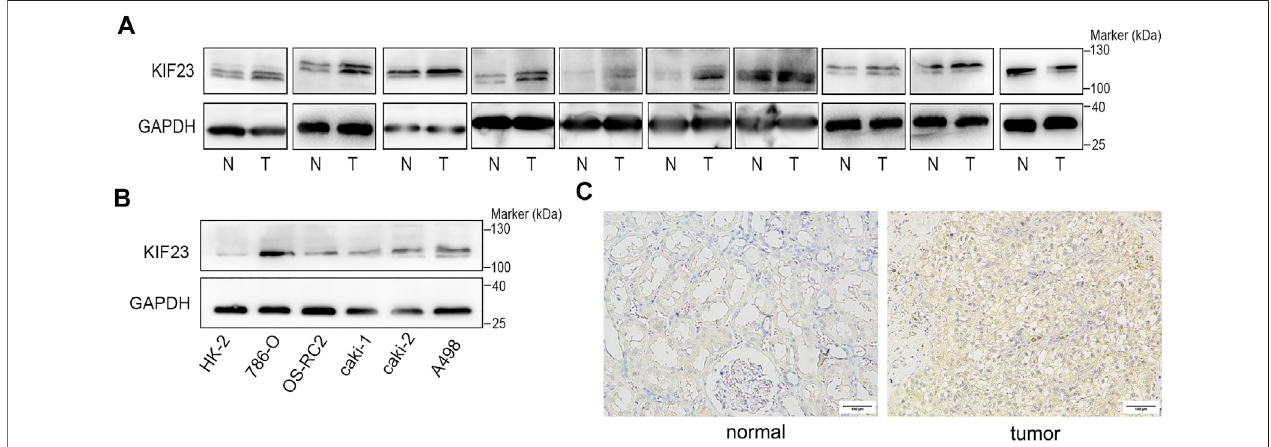
FIGURE 8 | KIF23 is overexpressed in ccRCC cell lines and tissues. (A) The expression level of KIF23 in 10 paired ccRCC samples. (B) KIF23 protein levels in ccRCC cell lines (786-O, OS-RC-2, caki1, caki2, and A498) and HK-2 were assessed using Western blot assays. (C) Immunohistochemistry staining of KIF23 expression level in ccRCC